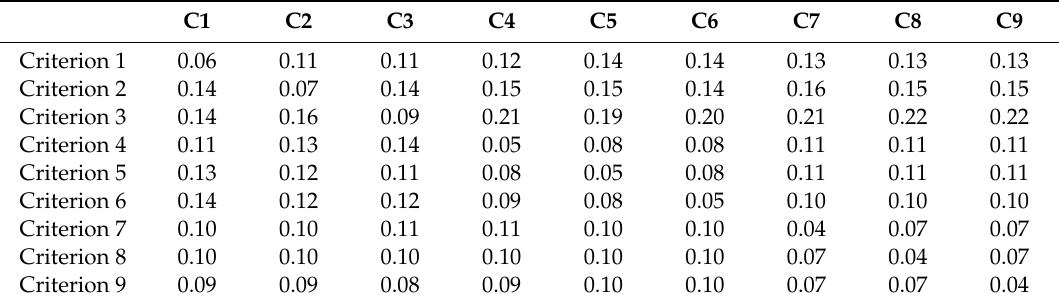
Table 7. Weighted supermatrix.